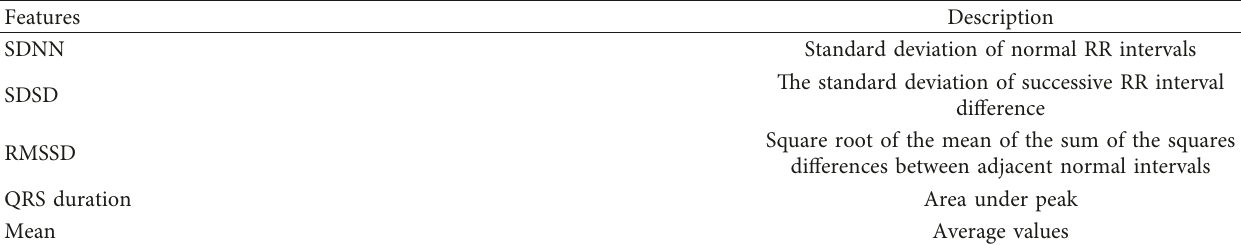
Table 1: Parameters of ECG.